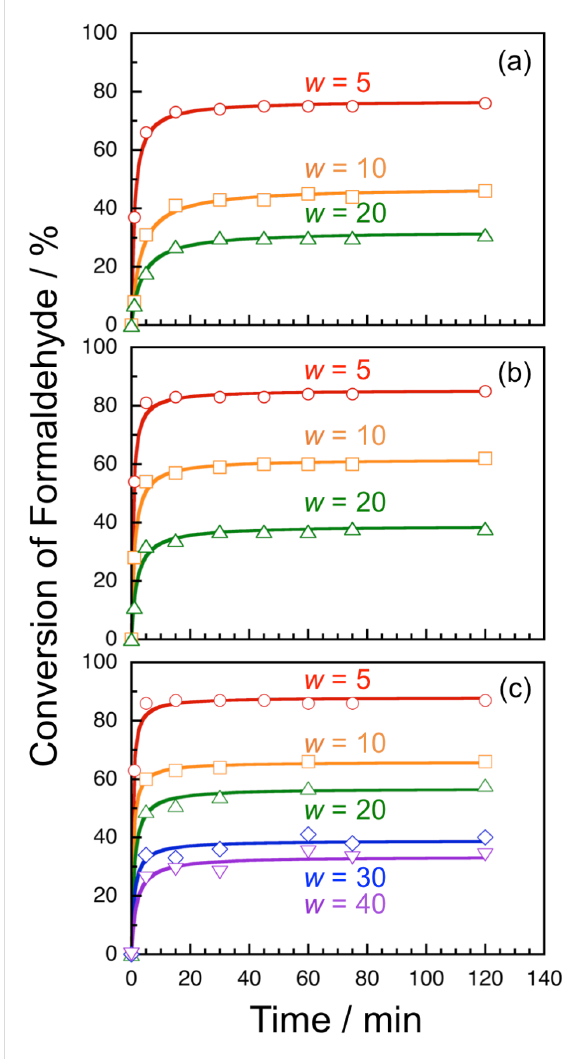
Figure 2: Time–conversion plots for formose reactions in AOT reverse micelles of different w at 30 (a), 45 (b), and 60 °C (c). Curves indicate the best fits using Equation 1.